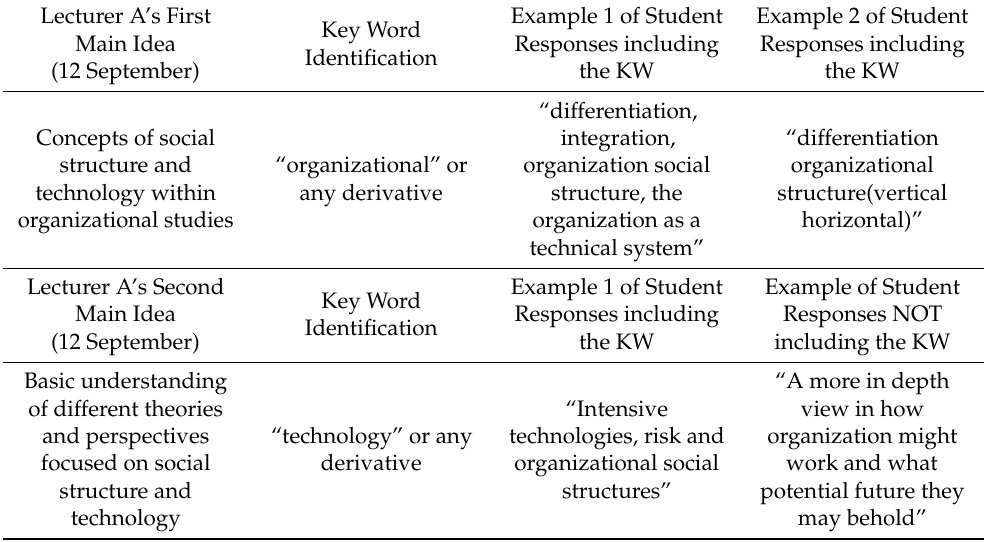
Table 1. Illustration of key word